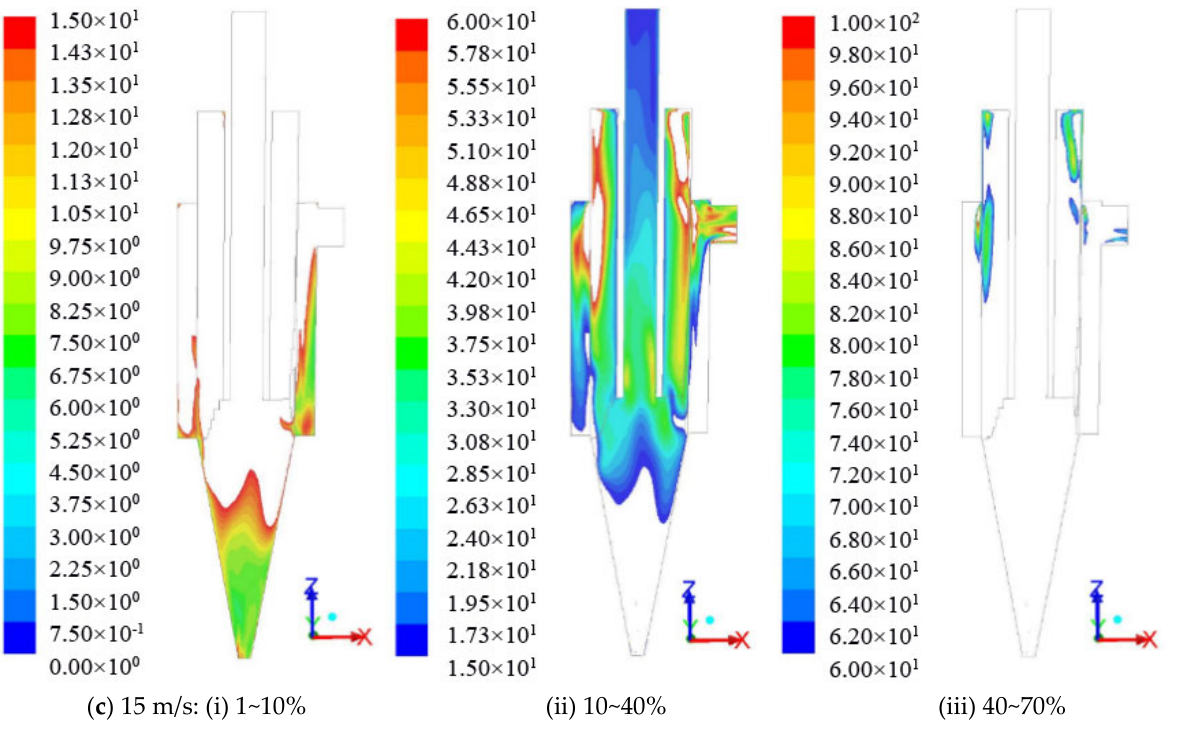
Figure 6. Distribution of turbulence intensity I (%) in TPHS.